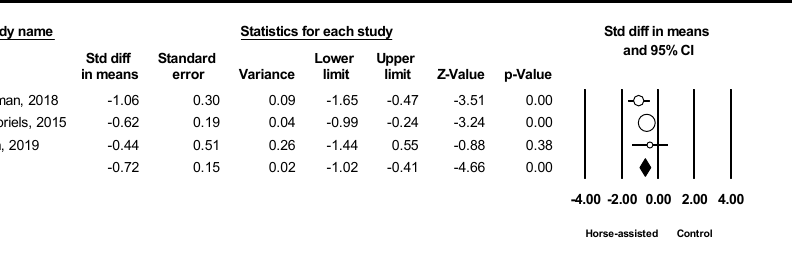
Figure 3. Forest plot showing the effects of horse-assisted therapy vs. control on social awareness [31,43,44,46]. The pooled meta-analysis results from the four studies in Figure 4 showed that horse- assisted therapy significantly improved social cognition in children with autism (SMD = − 0.75, 95% CI [ − 1.32, − 0.18], p < 0.001). Figure 4. Forest plot showing the effects of horse-assisted therapy vs. control on social cognition [31,43,44,46]. The pooled meta-analysis results from the four studies in Figure 5 showed that horse- assisted therapy significantly improved social motivation in children with autism (SMD = − 0.43, 95% CI [ − 0.71, − 0.16], p < 0.001).